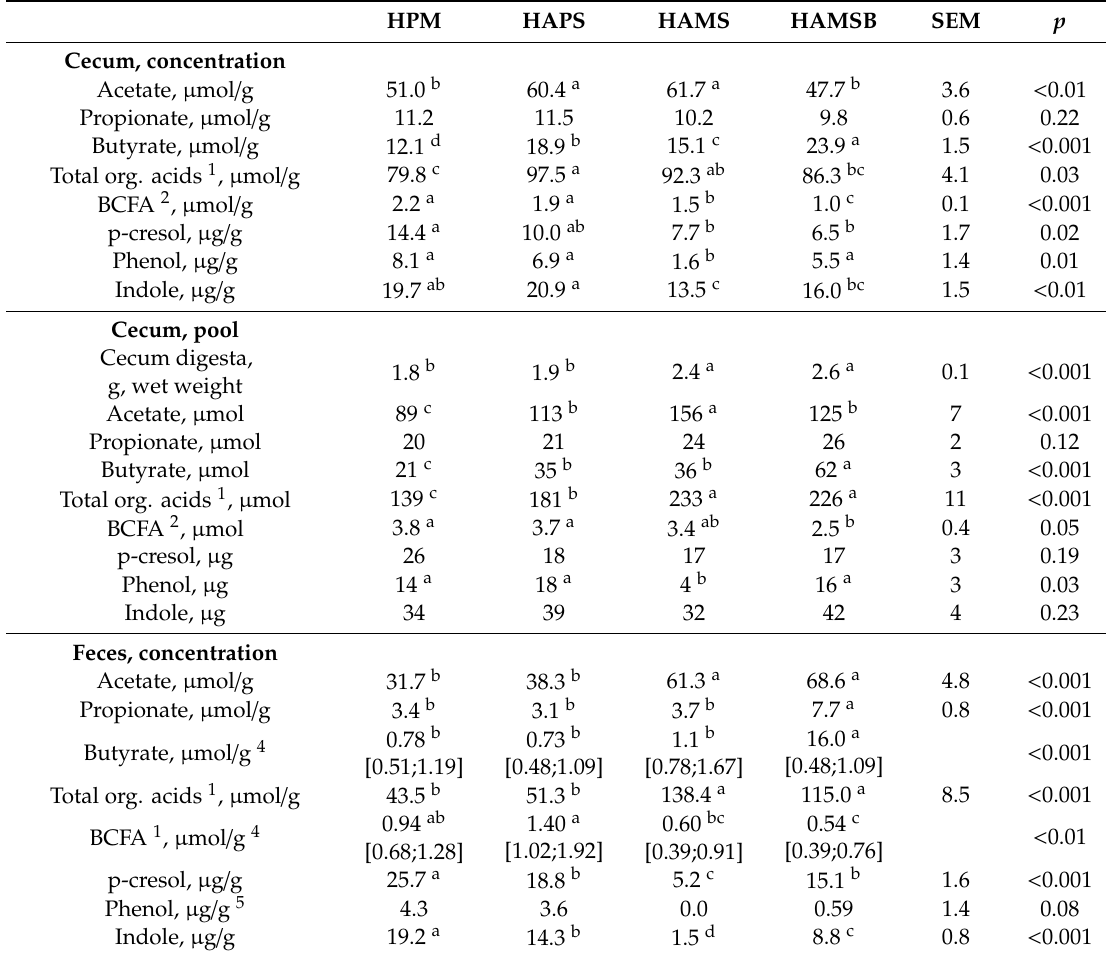
Table 1. Selected carbohydrate and protein fermentation products in the cecum digesta and feces of rats fed the four di ff erent diets (high-protein meat, HPM; high-amylose potato starch, HAPS; high-amylose maize starch, HAMS; butyrylated high-amylose maize starch, HAMSB). Least square mean values with their standard errors, n = 10 per